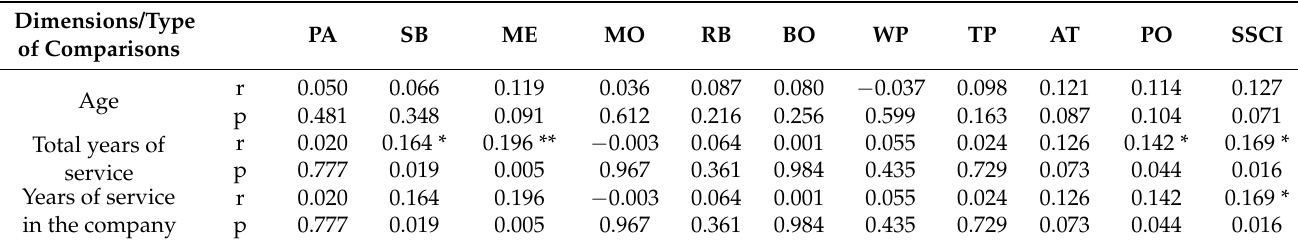
Table 1. Assessment of correlation relationship for selected diagnostic variables in individual dimen- sions of safety